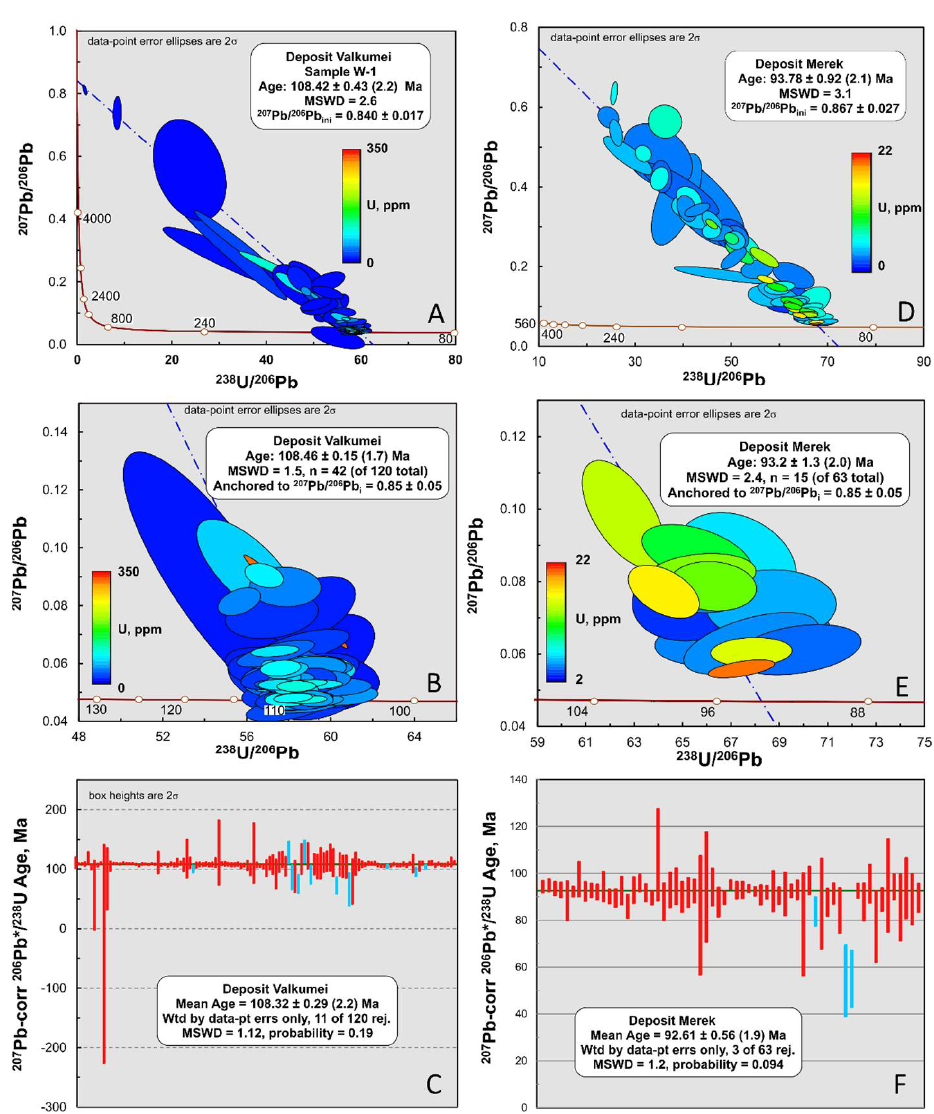
Figure 16. The U-Pb isotope data for cassiterite samples W-1 ( A – C ) and MK-1 ( D – F ) from the Valkumei and Merek deposits. Tera-Wasserburg isochron diagrams ( A , B , D , E ) and weighted averages of the 207 Pb-corrected 206 Pb*/ 238 U ages ( C , F ) are also shown. The vertical lines in ( C , F ) represent age values with 2 standard error (2 SE) bars. The blue lines are outliers not included in the weighted average calculation.